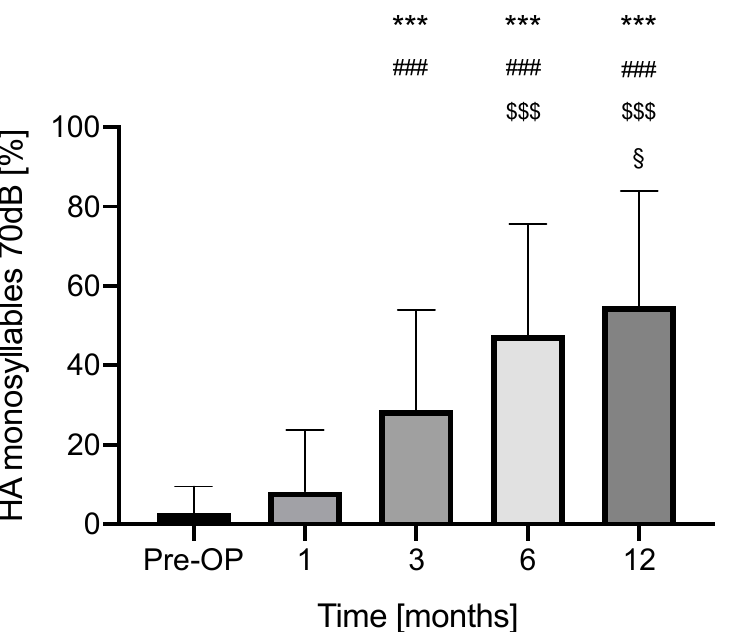
Figure 1. Aided (HA) speech understanding at 70 dB (Freiburger monosyllable test) preoperatively (with hearing aid), at 1, 3, 6 and 12 months postoperatively (with CI) in the whole patient cohort. Significant differences ( p < 0.05) are indicated in comparison with * vs. Pre-OP, # vs. 1 month, $ vs. 3 months, § vs. 6 months. Significance levels are indicated as **/##/$$/§§ if p < 0.005 and as ***/###/$$$/§§§ if p < 0.0001. Figure 1 Speech intelligibility for monosyllables.